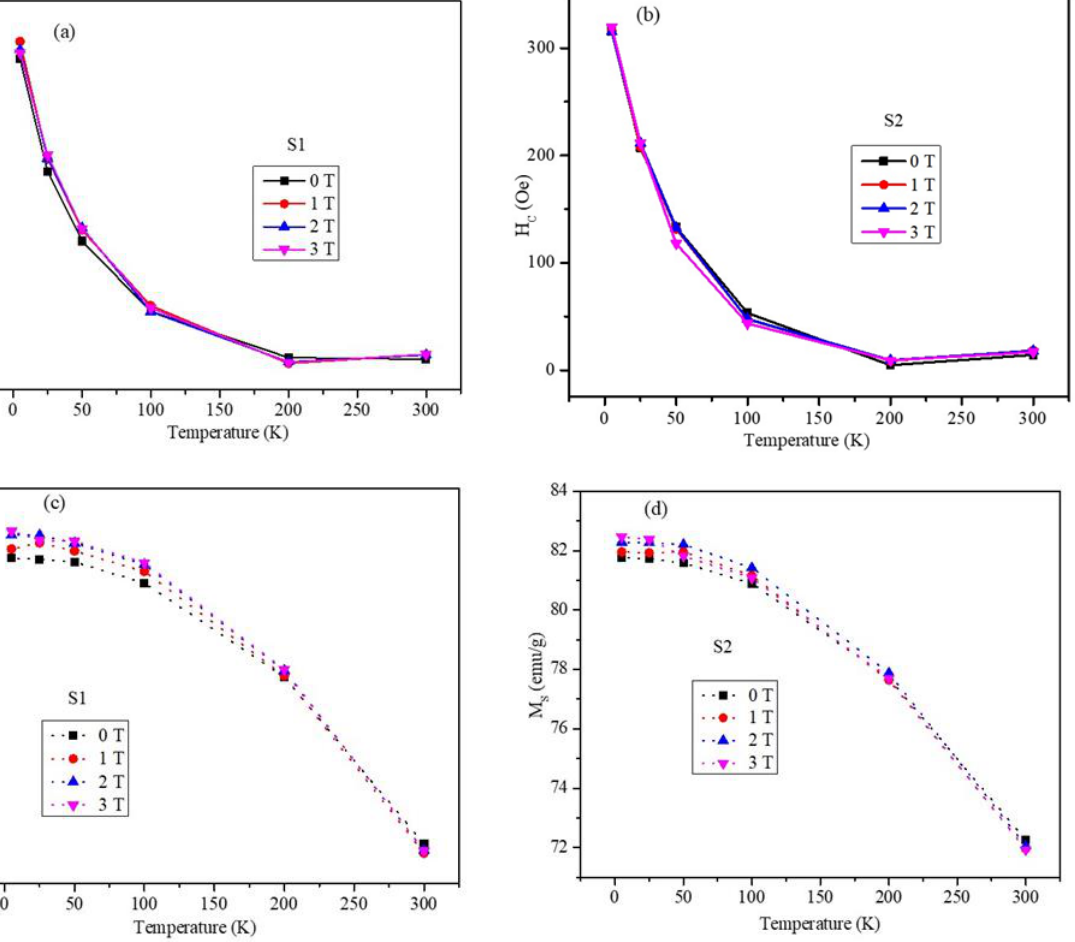
Figure 6. Coercivity as a function of temperature and field cooling for the 0, 1, 2, and 3 T field-cooling values for the ( a ) S1 and ( b ) S2 nanoparticles. Saturation magnetization as a function of temperature and field cooling for the 0, 1, 2, and 3 T field-cooling values for the ( c ) S1 and ( d ) S2 nanoparticles.